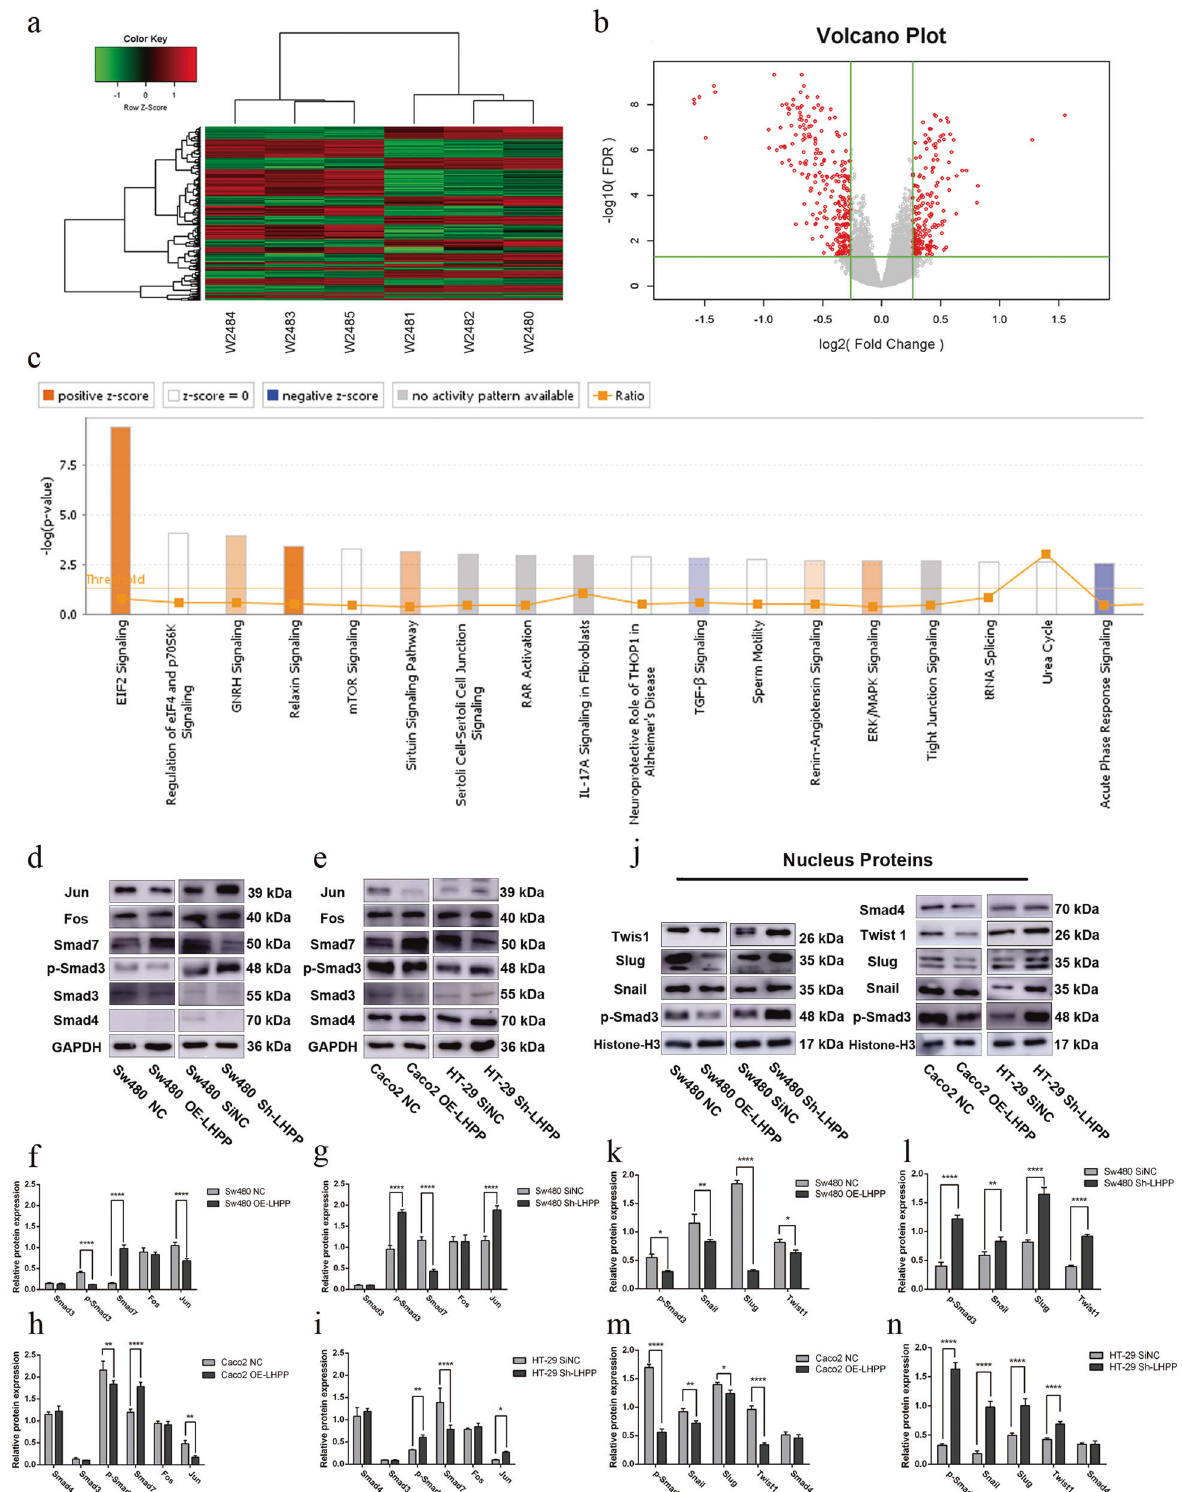
investigate the speci fi city of the TGF- β /Smad pathway in CRC progression, Sw480, Caco2, and HT-29 cells were pretreated with different concentrations of SIS3 for ~4 – 6 h. Subsequently, TGF- β 1 (5 ng/ml) was added into the medium after serum starvation for 24 h. In Supplemental Fig. 5, SIS3 markedly reduced the expression level of